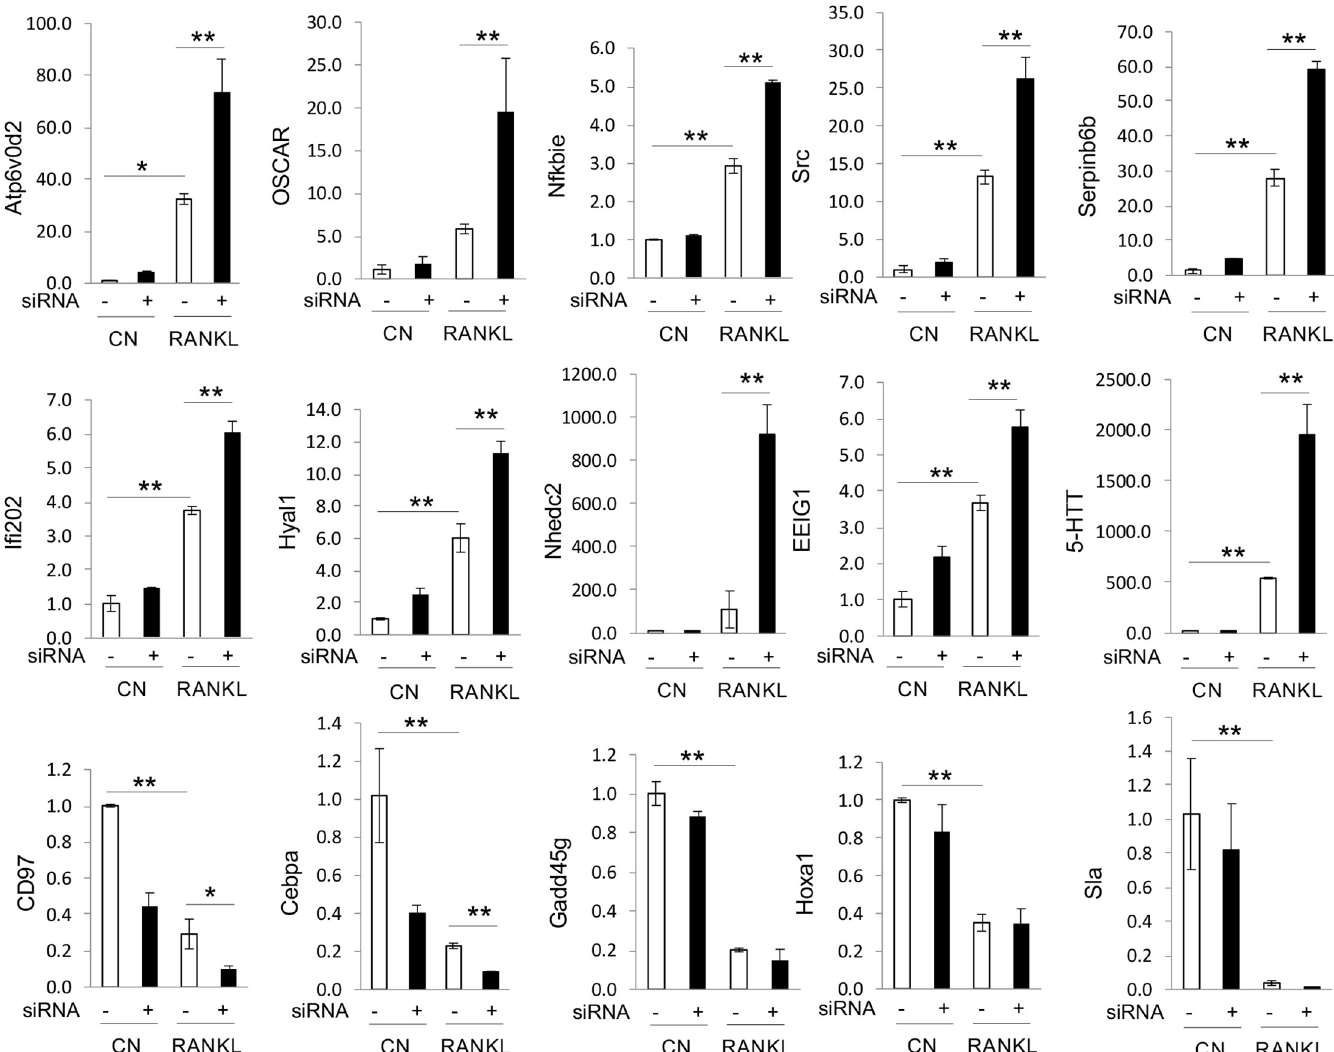
Fig 8. Real-time PCR analysis of genes upregulated or downregulated by STAT3. These genes were identified by microarray analysis. Three independent cell experiments were carried out. � p < 0.01, �� p < 0.001.